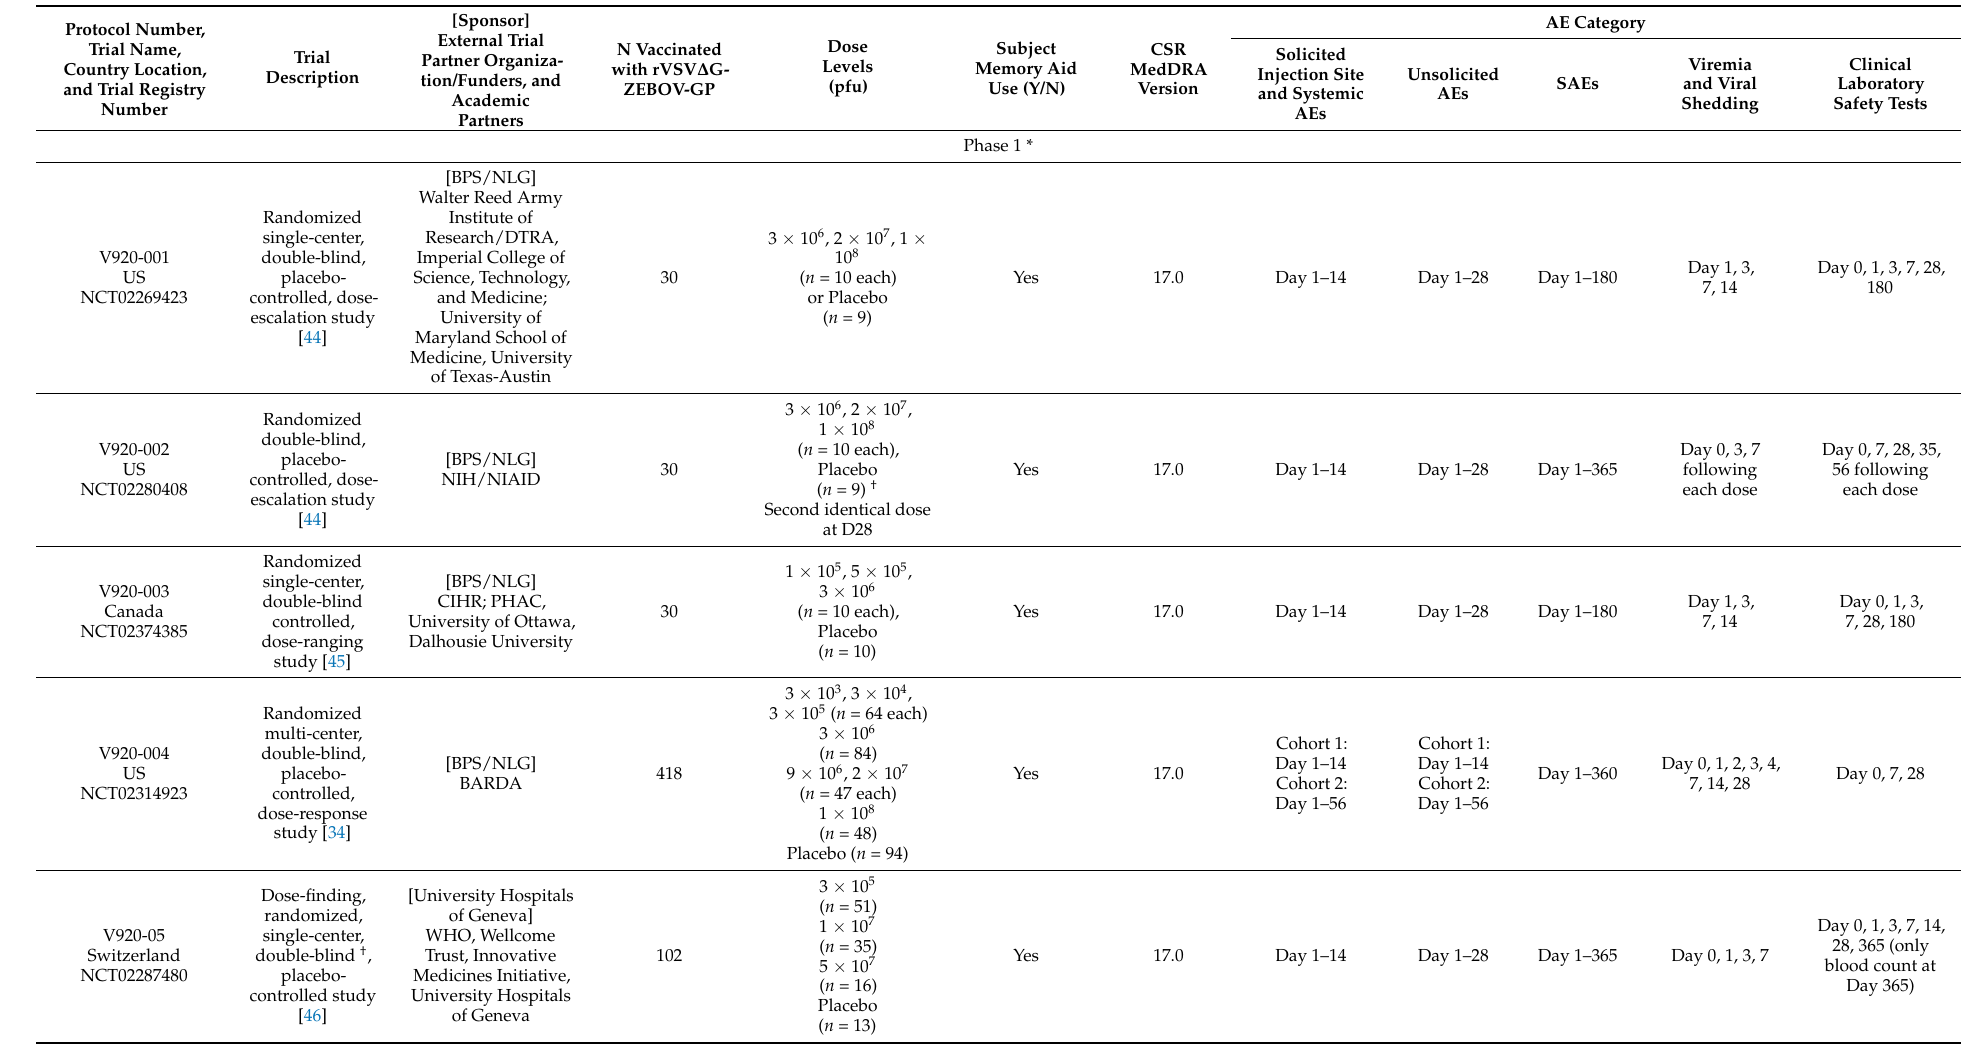
Table 2. Summary of clinical trial